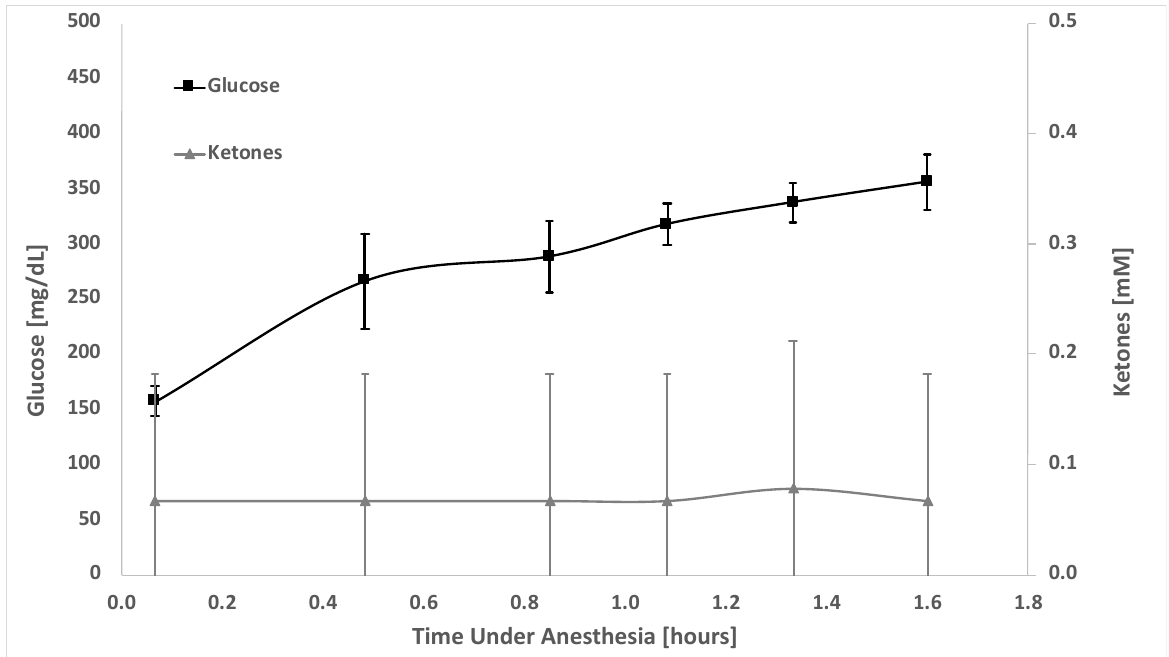
Figure 3. Ketone and glucose levels in the blood of control CD hairless rats. Ketones and glucose were measured in blood (via a tail snip), using a glucose/ketone test meter, at different time intervals over a 2.0 h ISF extraction experiment. Triplicate measurements were made for each metabolite at each time point. Glucose (squares, black); ketones (triangle, grey). Number of animals (N) = 3. Left y-axis shows glucose in mg/dL whereas the right y-axis shows ketones in mM. Time the animal was under 2% isoflurane anesthesia is shown on the x-axis.